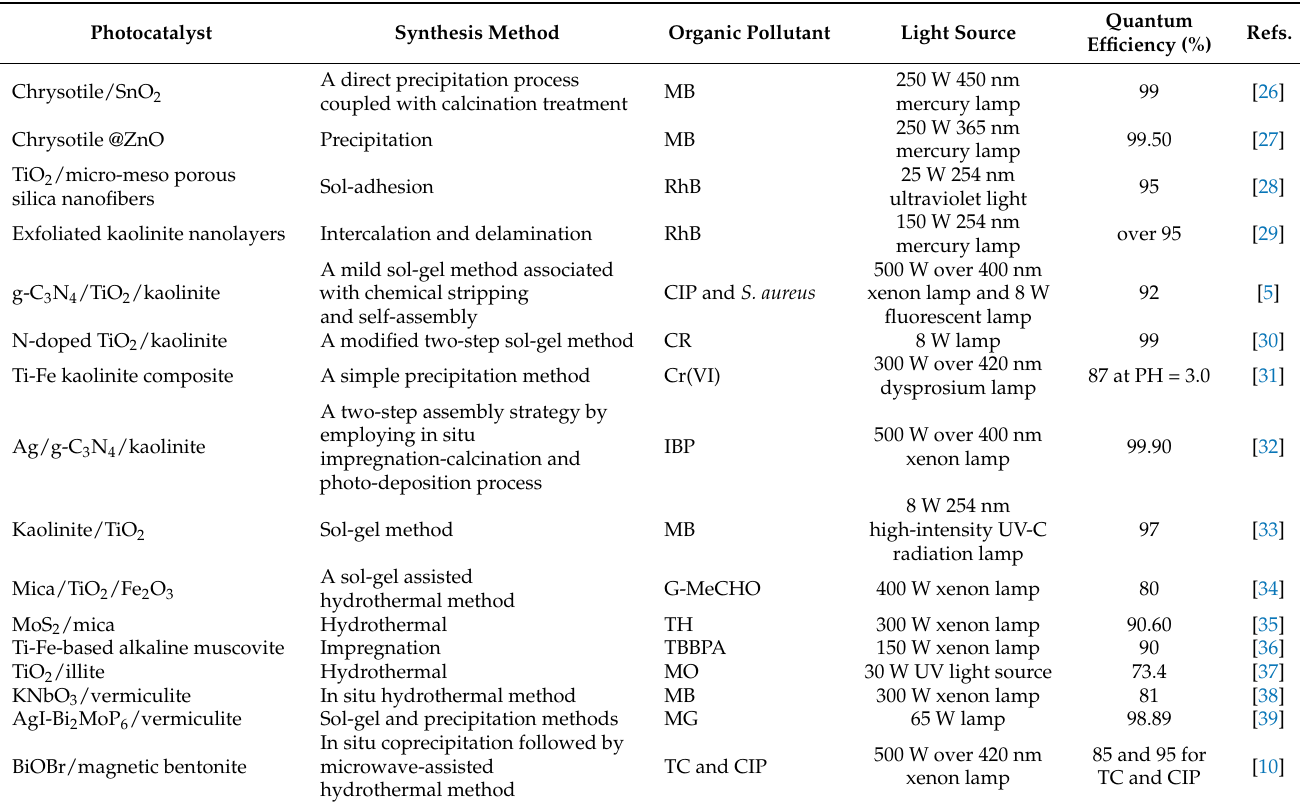
Table 1. Photocatalysts prepared using different minerals as support